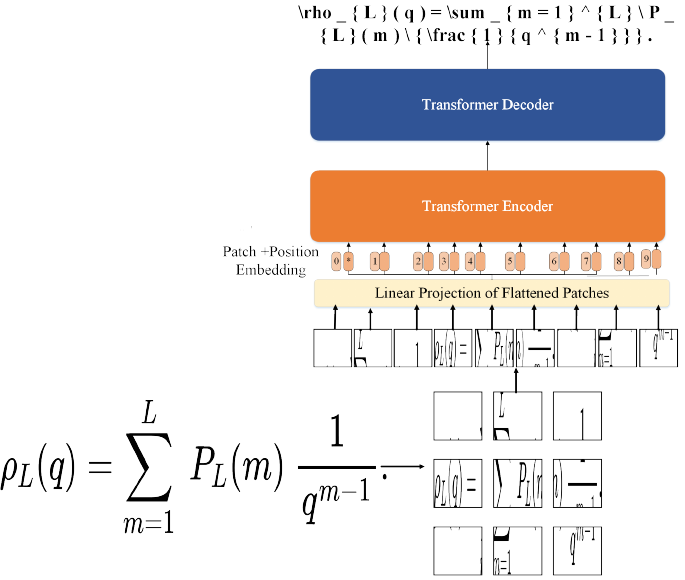
Figure 2. Overall architecture of this